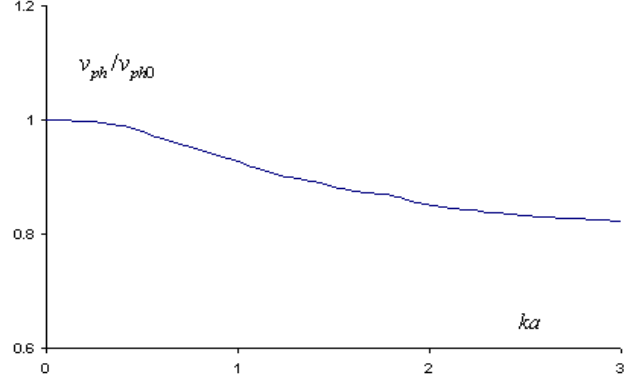
FIG. 20. (Color) Normalized capacitance per meter vs ka for a=b (cid:3) 0 : 6 and " (cid:3) " . 0